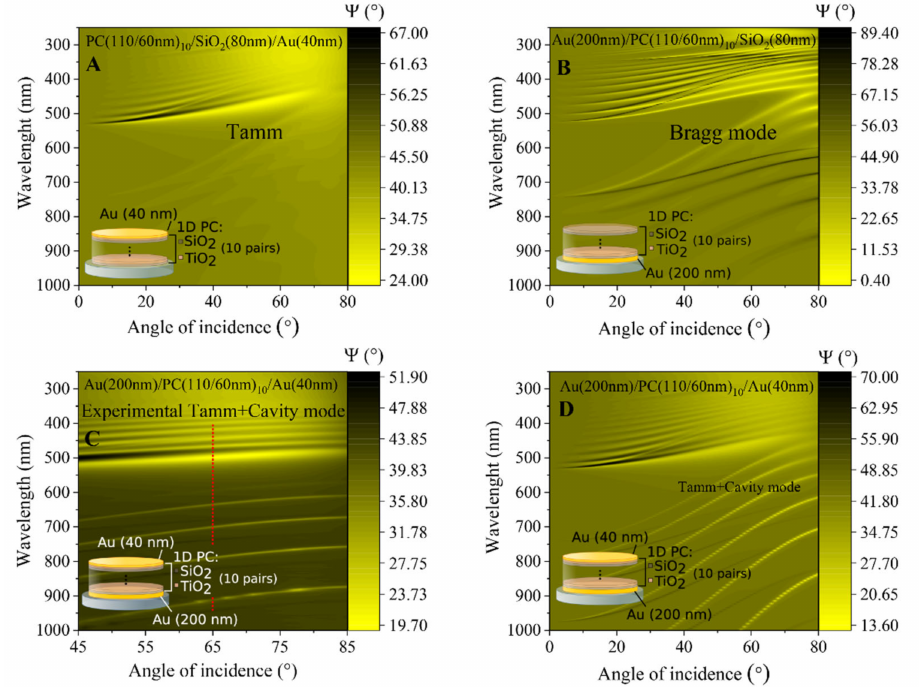
Figure 3. Dispersion relations of calculated TPP ( A ), cavity mode (CM) ( B ), TPP + CM ( D ), and an experimental dispersion of the investigated modified QCM-D sensor chip, supporting TPP and CM ( C ). Red dashed line in ( C ) marks a cross-section at θ i = 65 ◦ . In order to compare the optical signal sensitivity of standard QCM-D sensor chip covered by 200 nm gold (QCM-D) and modified QCM-D sensor chip supporting Tamm plasmon polariton and cavity modes, both were tested by varying the refractive index of liquid ambient by changing deionized water to the ethanol in the SE-QCM-D chamber for measurements in liquids. This chamber was filled with high purity deionized water and spectra of ellipsometric parameters Ψ ( λ ) and ∆ ( λ ) were measured for both samples, standard QCM-D sensor chip and modified QCM-D/TPP + CM at the AOI = 65 ◦ . Firstly, the chamber was filled with high purity water which acted as a bulk media having refractive index n = 1.333 at λ = 600 nm. After that, high-purity deionized water was changed to ethanol bulk medium, which has a refractive index of n = 1.361 at λ = 600